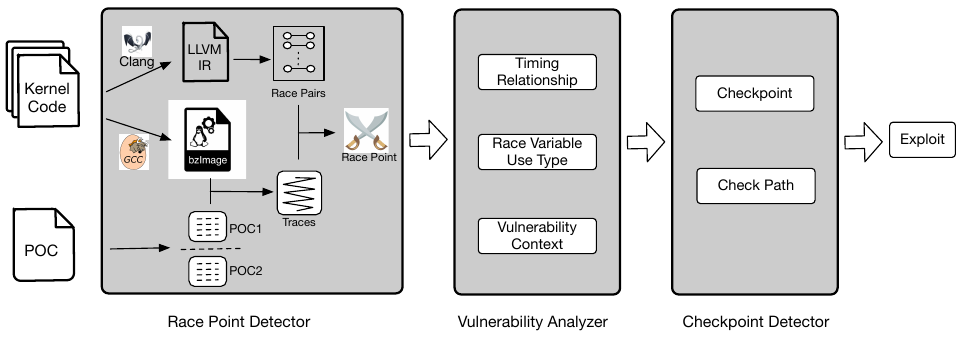
Figure 5. Overview of ERACE